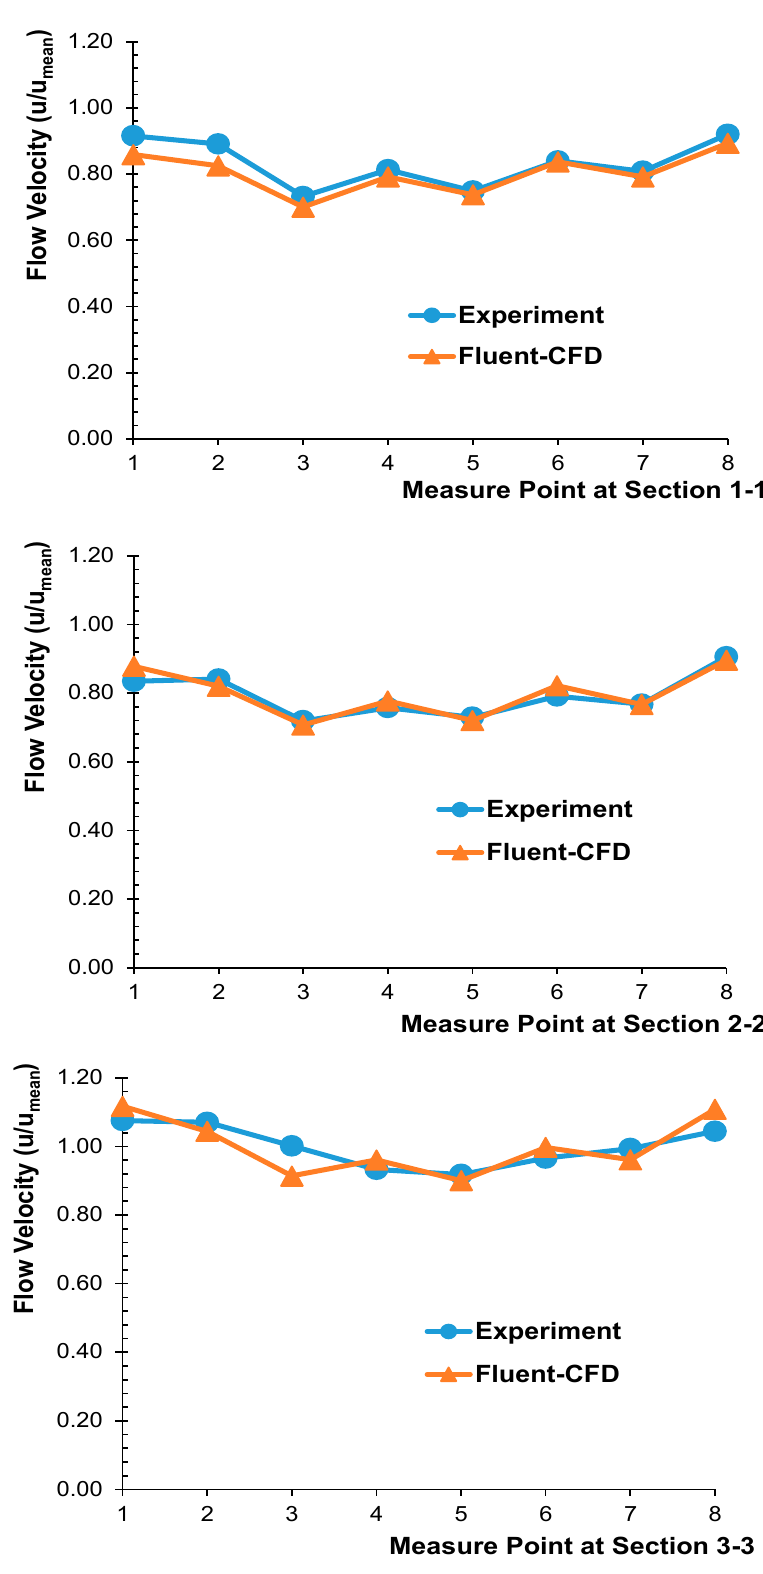
Figure 9. Flow velocity changes for ‘with vanes’ situation at sections; 1-1, 2-2 and 3-3.